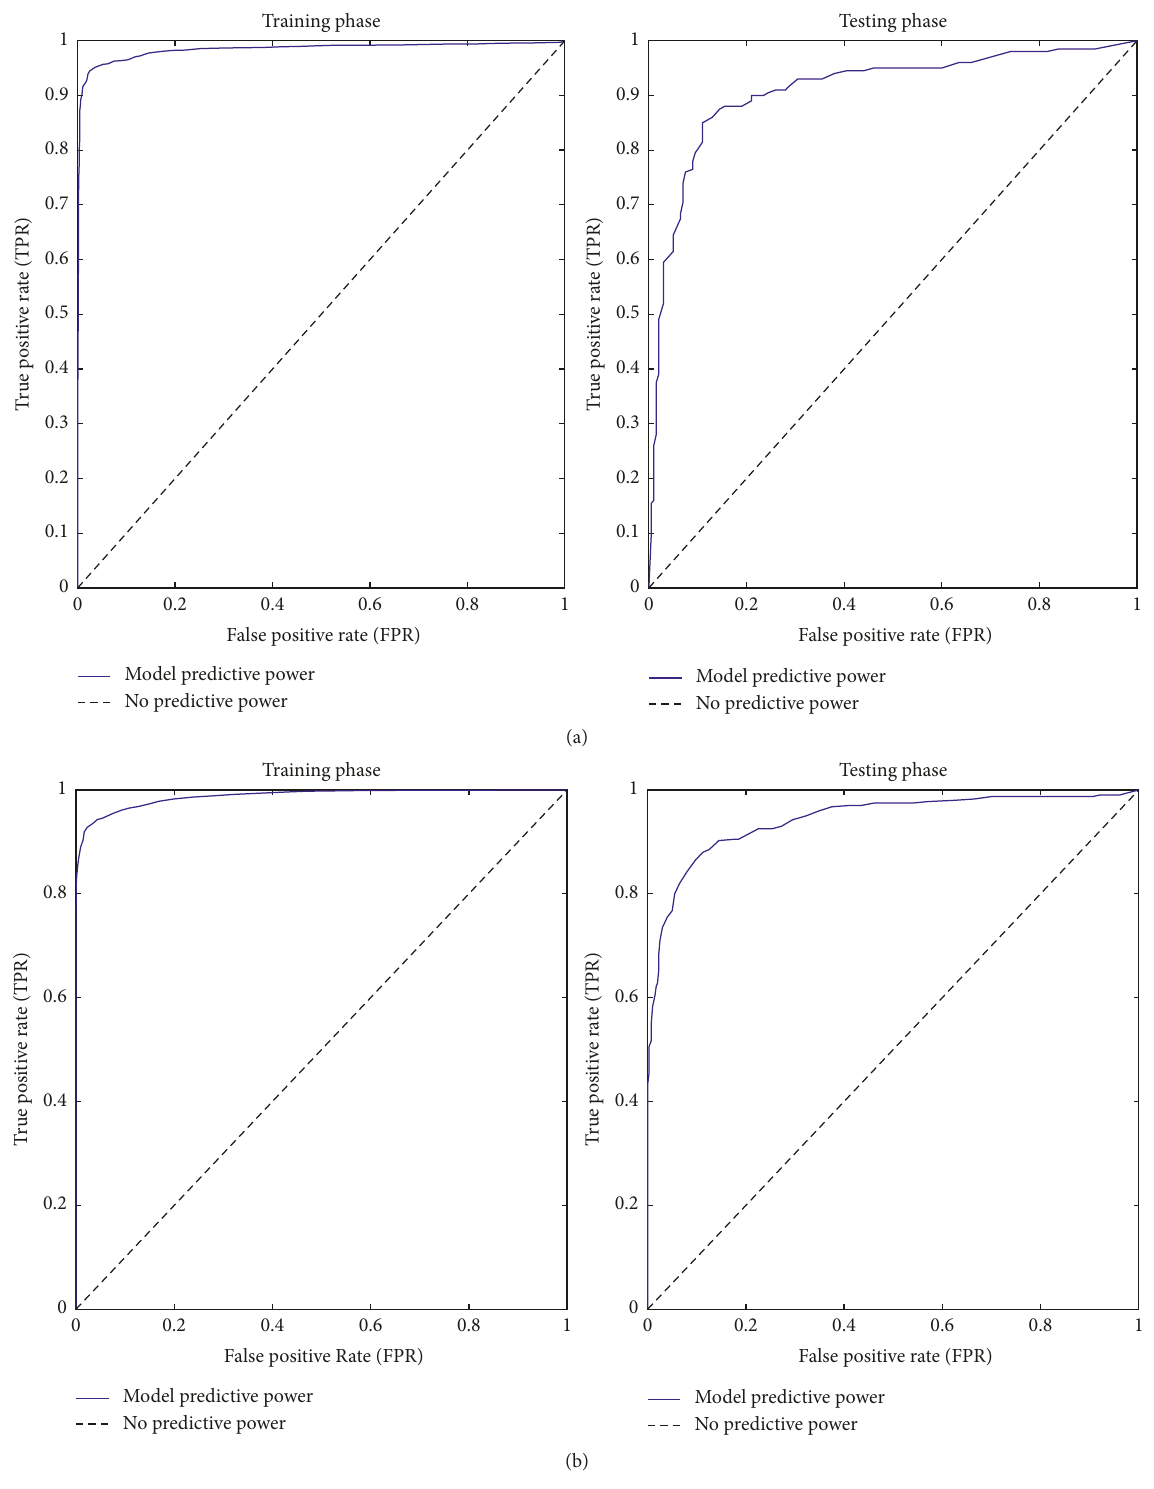
Figure 9: ROC of the ANN and LS-SVM models: (a) ANN results and (b) LS-SVM